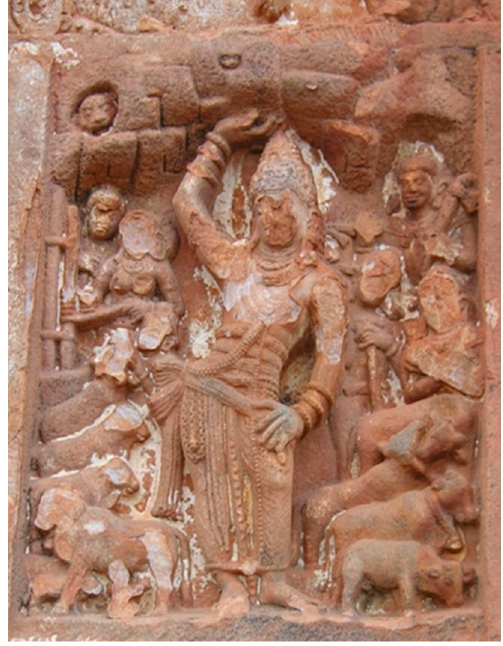
Figure 13. Govardhanadhara, sixth–seventh century. Southern wall, Upper Ś iv ā laya, B ā d ā m ī , Karnataka (photo by courtesy of Dominic Goodall, EFEO).